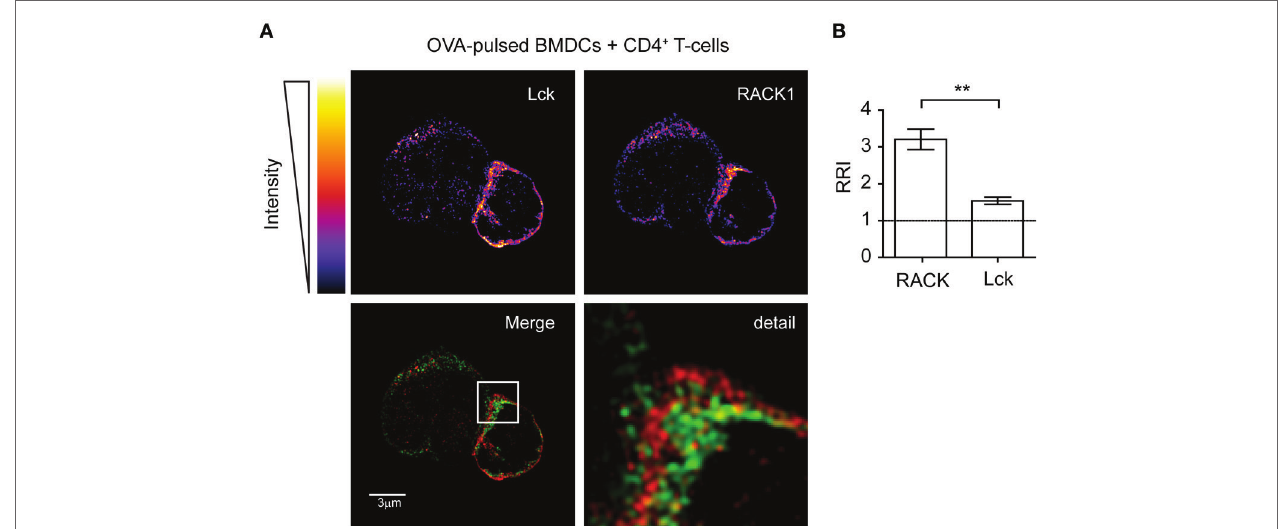
FigUre 2 | lck and racK1 in primary cD4 + T-cell co-redistribute into forming immunological synapse . (a) OVA-pulsed bone marrow-derived dendritic cells (BMDCs) were mixed with CD4 + T-cells from OTII transgenic mice. After 2–3 min, T-cell–APC conjugates were seeded on cover slips, fixed and probed with anti-Lck (red) and anti-RACK1 (green), and visualized by super-resolution N-SIM microscopy. The upper two panels show the fluorescence intensities of individual Lck or RACK1 signals using pseudocolor digital scaling. The panel titled “Detail” shows the magnification of the rectangle inset seen in the Merge image. An image of one representative cell conjugate is presented. Consistent with a previous report (52), the low expression of Lck was also detected in BMDCs. (B) Statistical analysis of the relative recruitment index (RRI) showed that while both RACK1 and Lck are enriched at the site of the forming IS, RRI for the former is significantly higher than that for Lck ( n = 20), p <